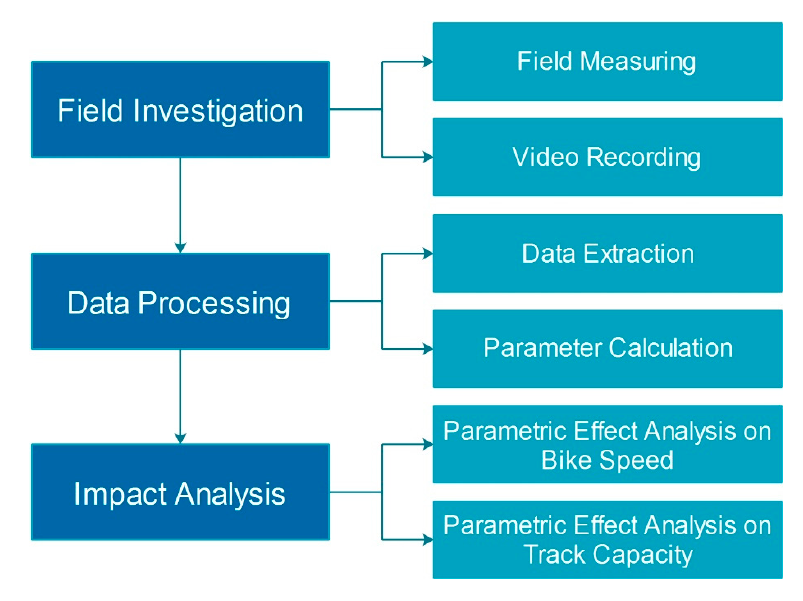
Figure 2. Flow chart of the study.